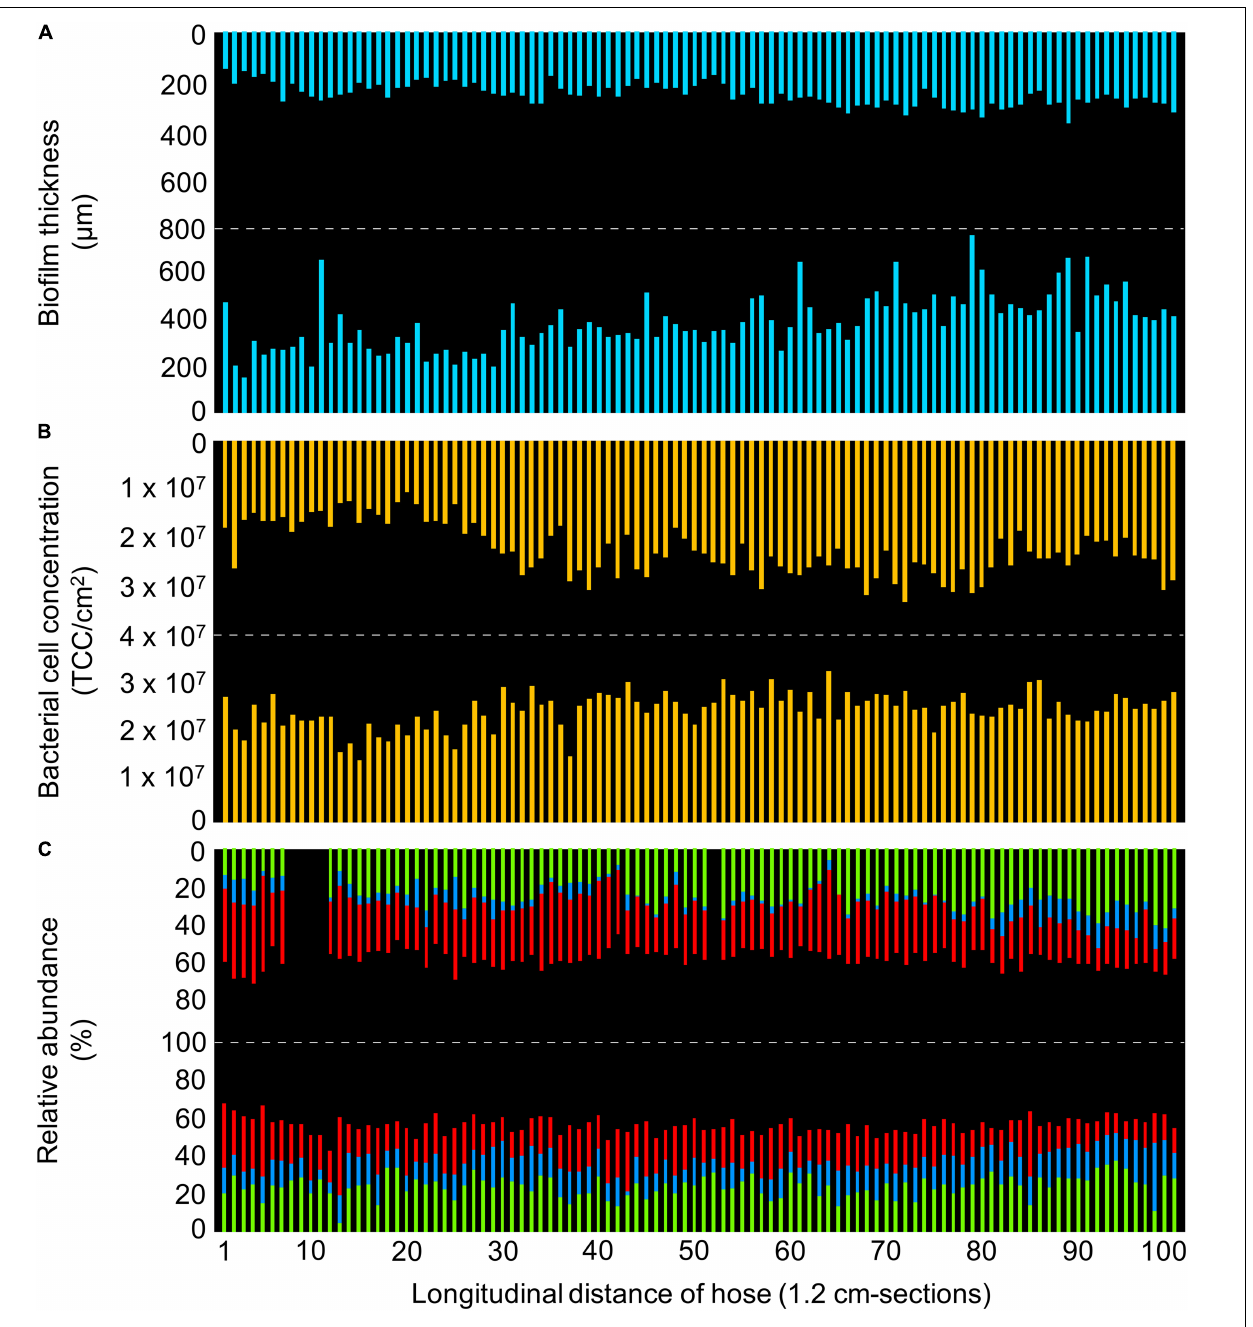
FIGURE 3 | Detailed characterization of the control hose biofilm, with bars representing individual sections of 1.2 cm. (A) Biofilm thickness measured with optical coherence tomography. (B) Bacterial cell concentrations measured with flow cytometry. (C) Community composition measured with 16S rRNA gene sequencing, showing the relative abundance of the three most abundant taxa (green: Cytophagaceae; blue: TM6_[Dependentiae]; red: Bradyrhizobium spp.). Data gaps resulted from insufficient DNA